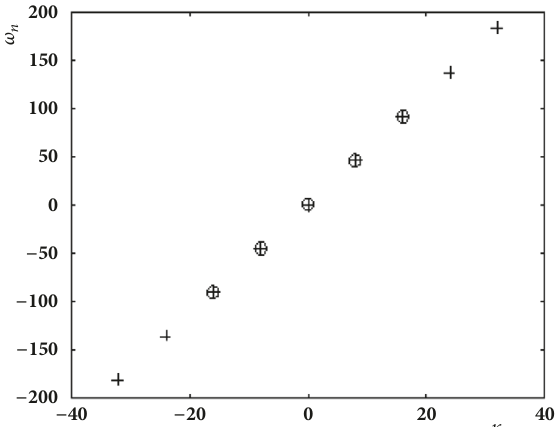
Figure 15: The 𝜔 - 𝜅 diagram (with circles and crosses indicating low and high accuracy) for the attractor at 𝑅 = 8 ⋅ 10 5 . r = 0.25